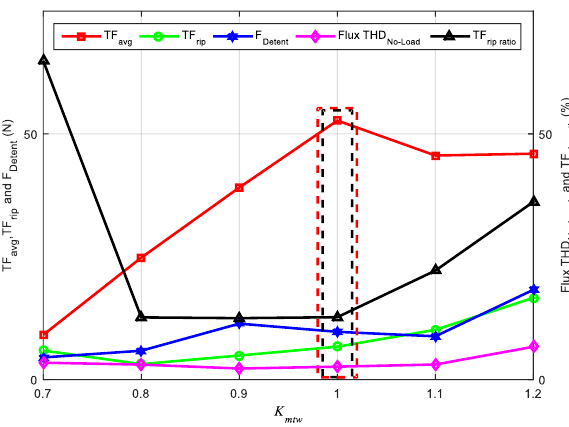
Figure 13. Influence of 𝐾 𝑚𝑡𝑤 on DSLFSPMM-MO2.